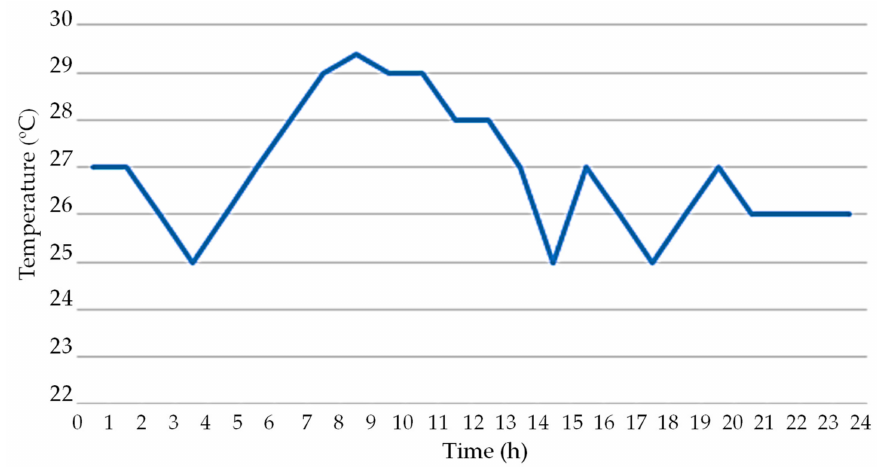
Figure 4. Considered values profile for the outside smart house temperature.